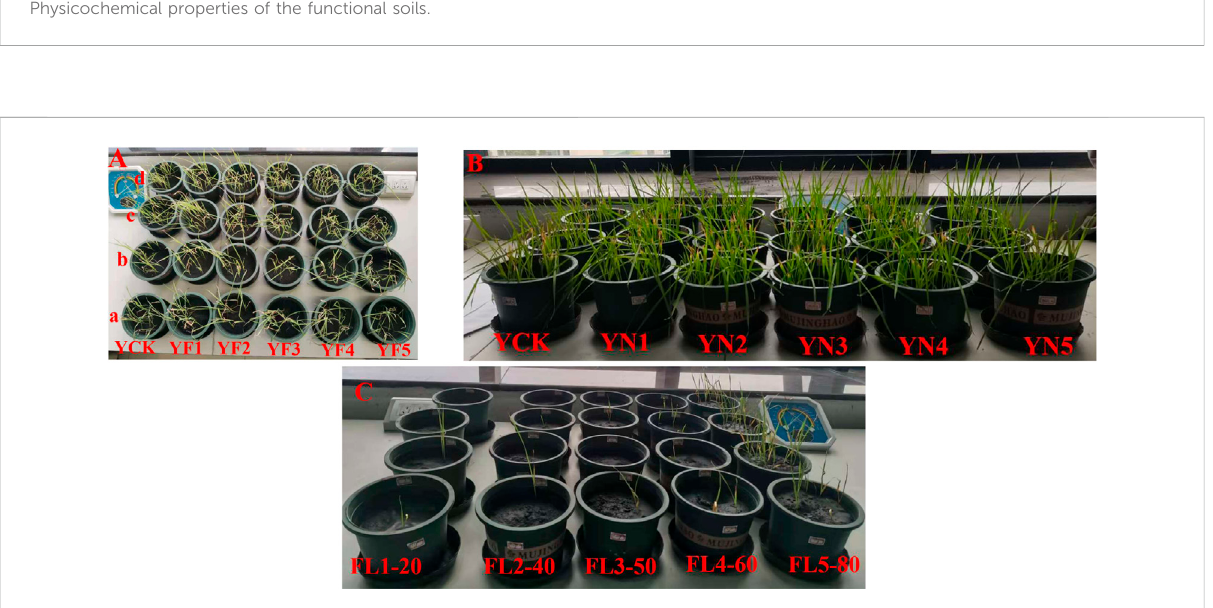
FIGURE 3 Plants used for three experiments on Day